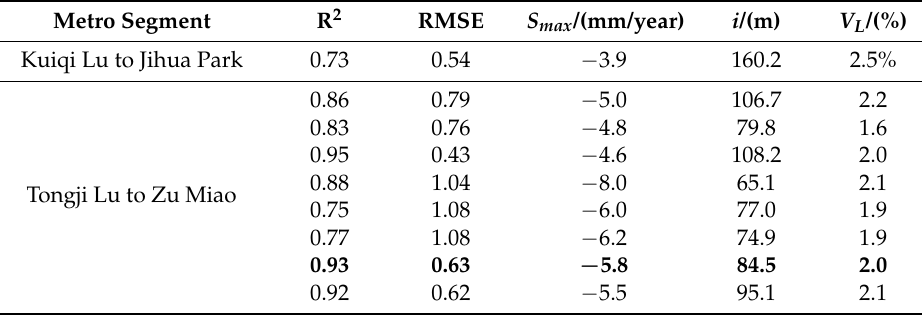
Table 1. Parameter list of profiles fitted by Peck’s